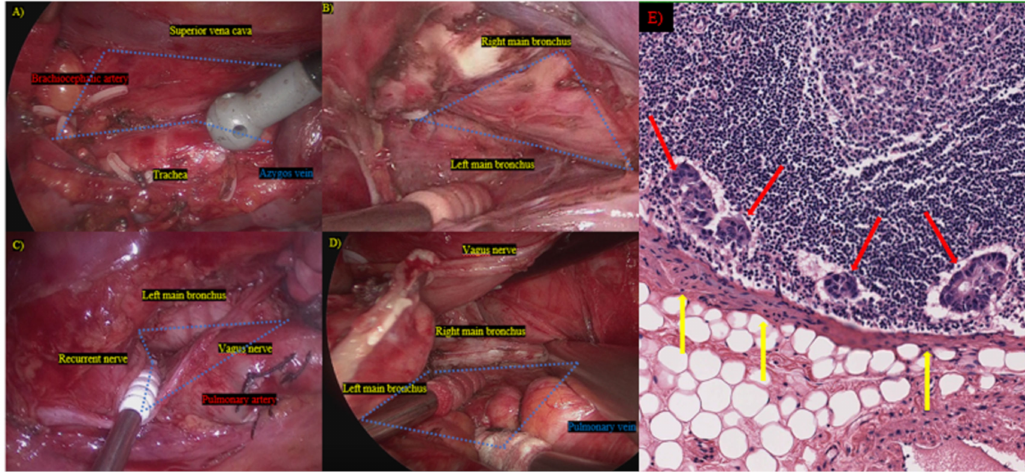
Figure 2. Mediastinal lymph node dissection and pathological findings. ( A ) Right upper mediastinum; ( B ) right bifurcation; ( C ) left upper mediastinum; ( D ) left bifurcation; blue area: mediastinal dissected region; ( E ) cancer cells disseminate from metastasized lymph nodes through the sheath of the lymph nodes; red arrow: metastasized lymph node; yellow arrow: disseminated cancer cells.